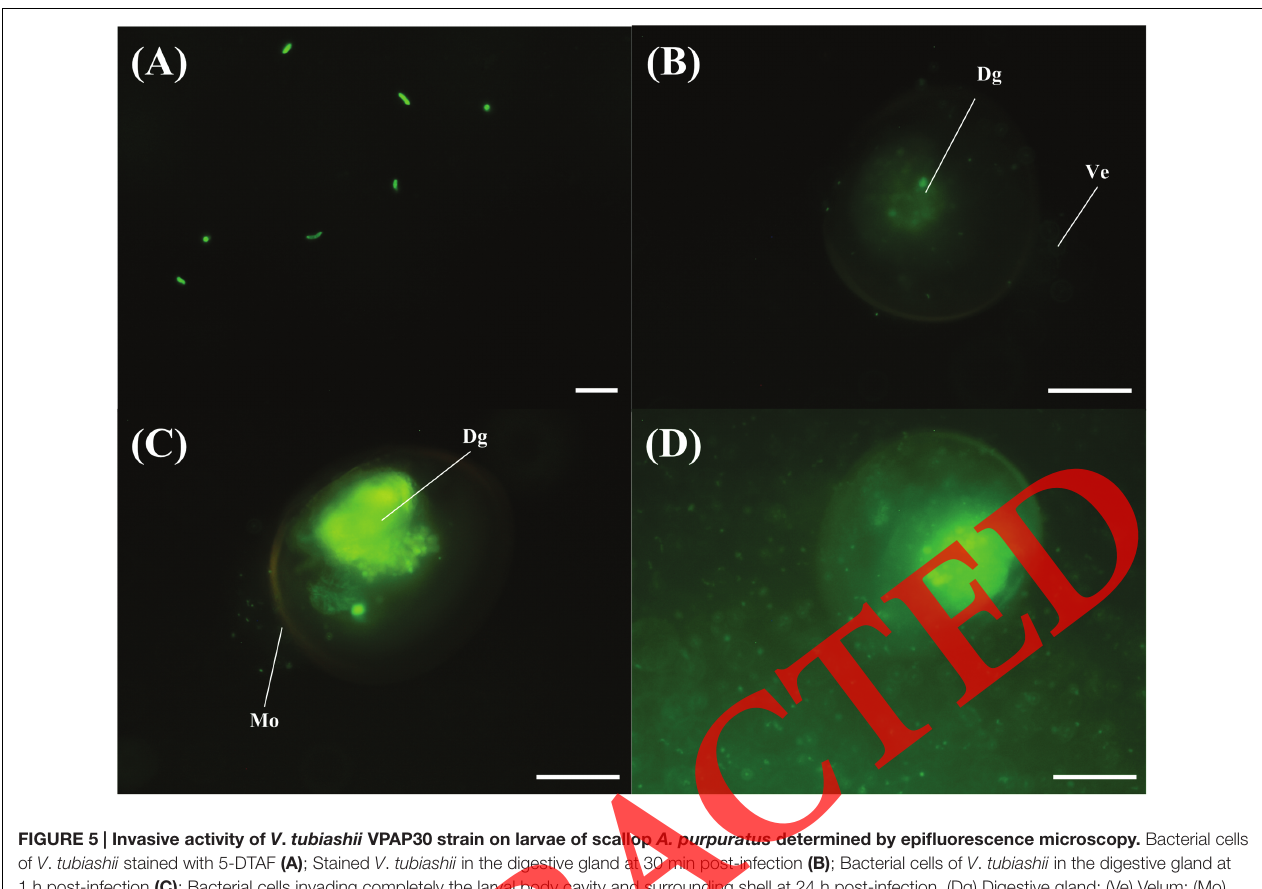
FIGURE 5 | Invasive activity of V . tubiashii VPAP30 strain on larvae of scallop A. purpuratus determined by epifluorescence microscopy. Bacterial cells of V . tubiashii stained with 5-DTAF (A) ; Stained V . tubiashii in the digestive gland at 30 min post-infection (B) ; Bacterial cells of V . tubiashii in the digestive gland at 1 h post-infection (C) ; Bacterial cells invading completely the larval body cavity and surrounding shell at 24 h post-infection. (Dg) Digestive gland; (Ve) Velum; (Mo) Mouth. Scale bars: 10 µ m (A) ; 50 µ m (B − D) .